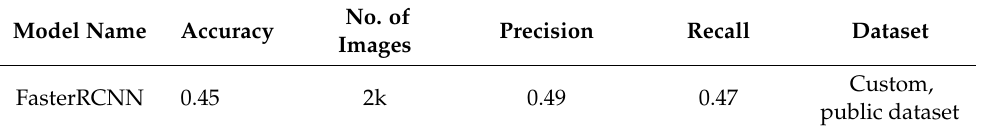
Table 7. FasterRCNN